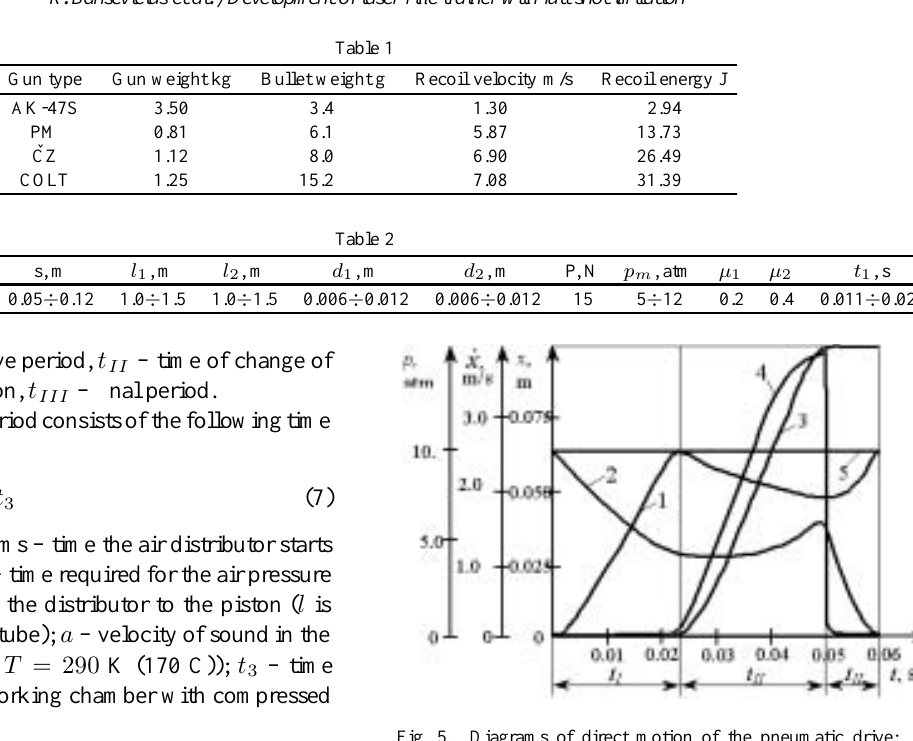
Fig. 5. Diagrams of direct motion of the pneumatic drive: 1 – pressure in the working chamber; 2 – pressure in the outlet chamber; 3 – piston shift; 4 – piston velocity; 5 – pressure in the main tube.